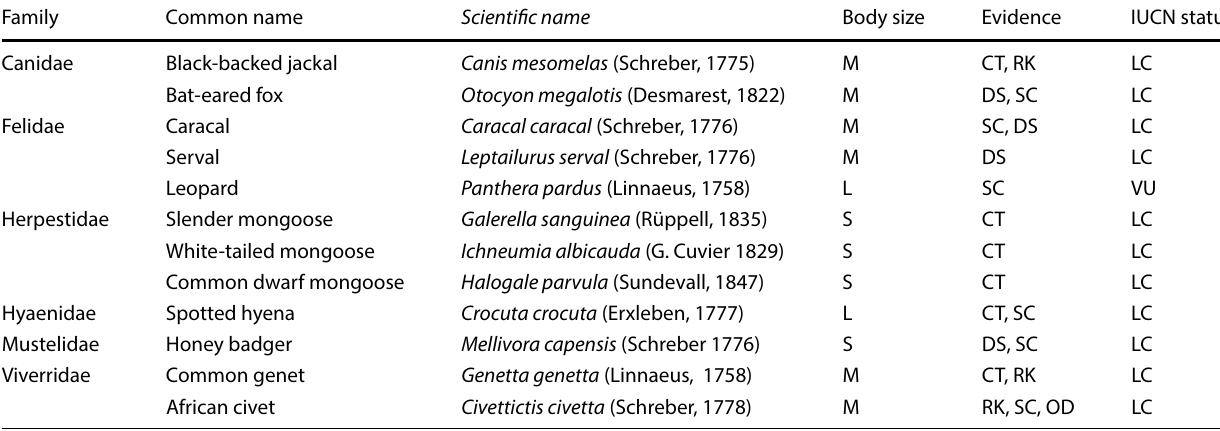
Table 1 Carnivore composition, sources of evidence, and conservation status in the FFL of Southern Rift Valley, Ethiopia